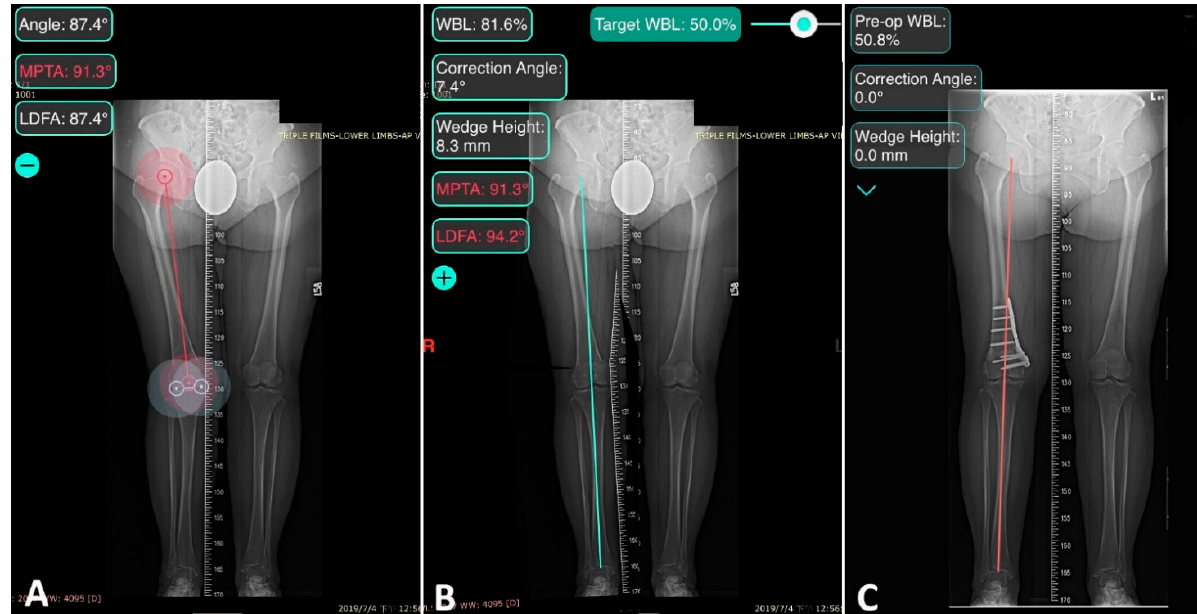
Figure 1. Digital Preoperative Planning. ( A ) The full-length weight-bearing AP radiograph of a 67-year-old female with valgus deformity of the right knee. The femorotibial angle, MPTA, and LDFA were measured automatically in the software. ( B ) A 2D simulation of the osteotomy, setting the target of correction at 50% on the WBL ratio. The correction angle, wedge height, and LDFA after correction were simulated by the software. ( C ) The full-length weight-bearing AP radiograph of the same patient one year after DFO. The WBL ratio was corrected to 50.8%.